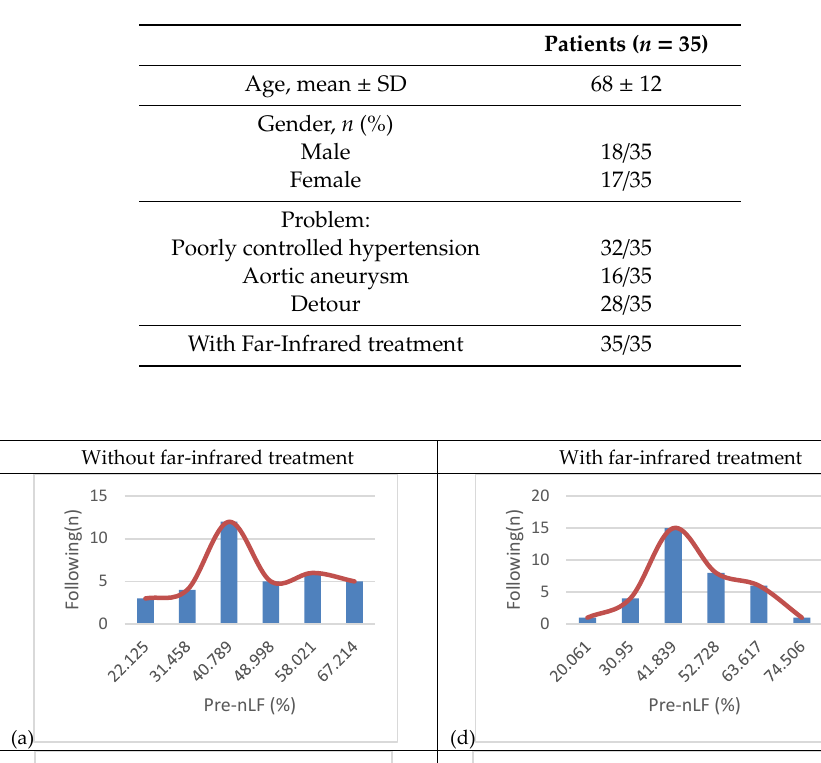
Table 1. List of the main clinical features.